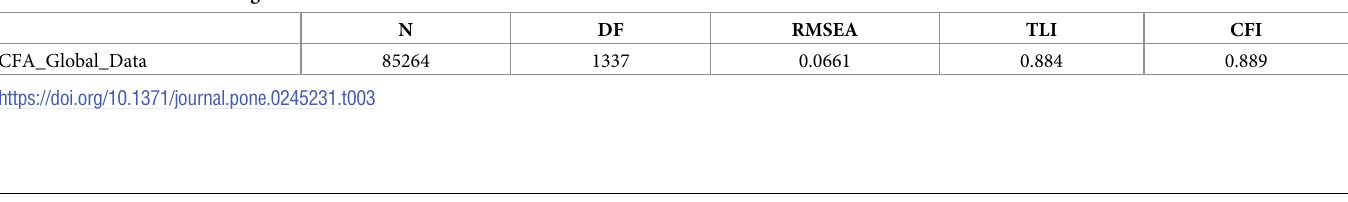
country for each of the 55 questions in the CFA. Each country sample is a similar size. This ensures that no single country dominates the data just because it contains more responses.